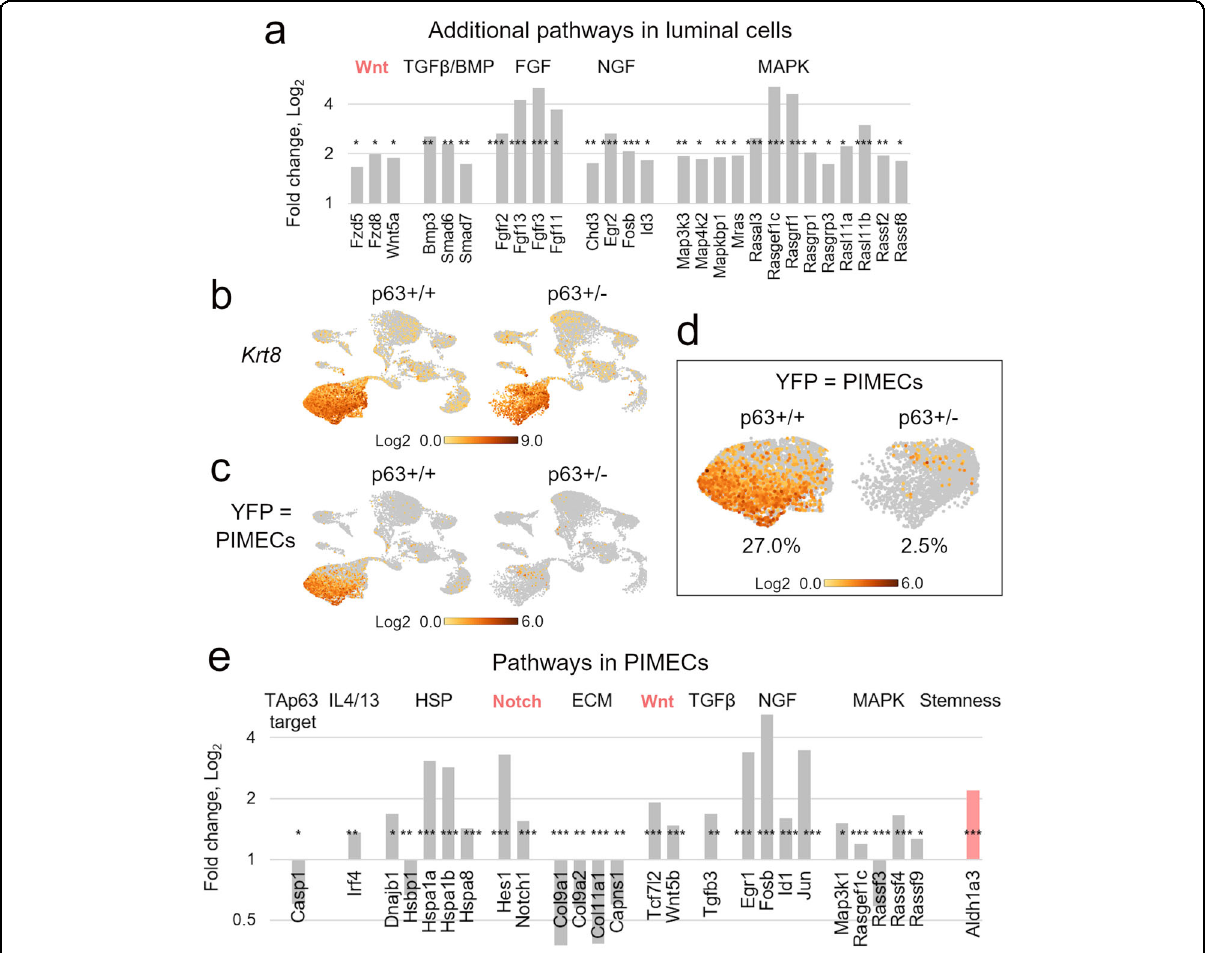
Fig. 5 Additional pathways in the luminal cluster and analysis of p63 + / − vs. p63 + / + PIMECs. a Additional pathways signi fi cantly altered in the p63 + / − vs. p63 + / + luminal cluster (de fi ned as in Fig. 3b, c) that were not revealed by Reactome. b – e Analysis of PIMECs, identi fi ed by YFP/Krt8 double expression. b , c UMAP plots of re-aggregated clusters upon addition of the exogenous YFP gene, Loupe browser. Note slightly shifted cell positions compared to Fig. 3b, c, due to YFP addition and re-aggregation. b Luminal marker Krt8 identi fi es the luminal cluster. c PIMECs are almost exclusively luminal cells, as expected. d A close-up of the luminal clusters. Note signi fi cant, >10-fold, decrease in the PIMECs number in p63 + / − vs. p63 + / + MECs ( d ). e Pathways signi fi cantly altered in PIMECs closely resemble those altered in the luminal cells as a whole ( a , also see Fig. 4). Pink, stemness and self-renewal pathways and genes. * p < 0.05, ** p < 0.01, *** p <